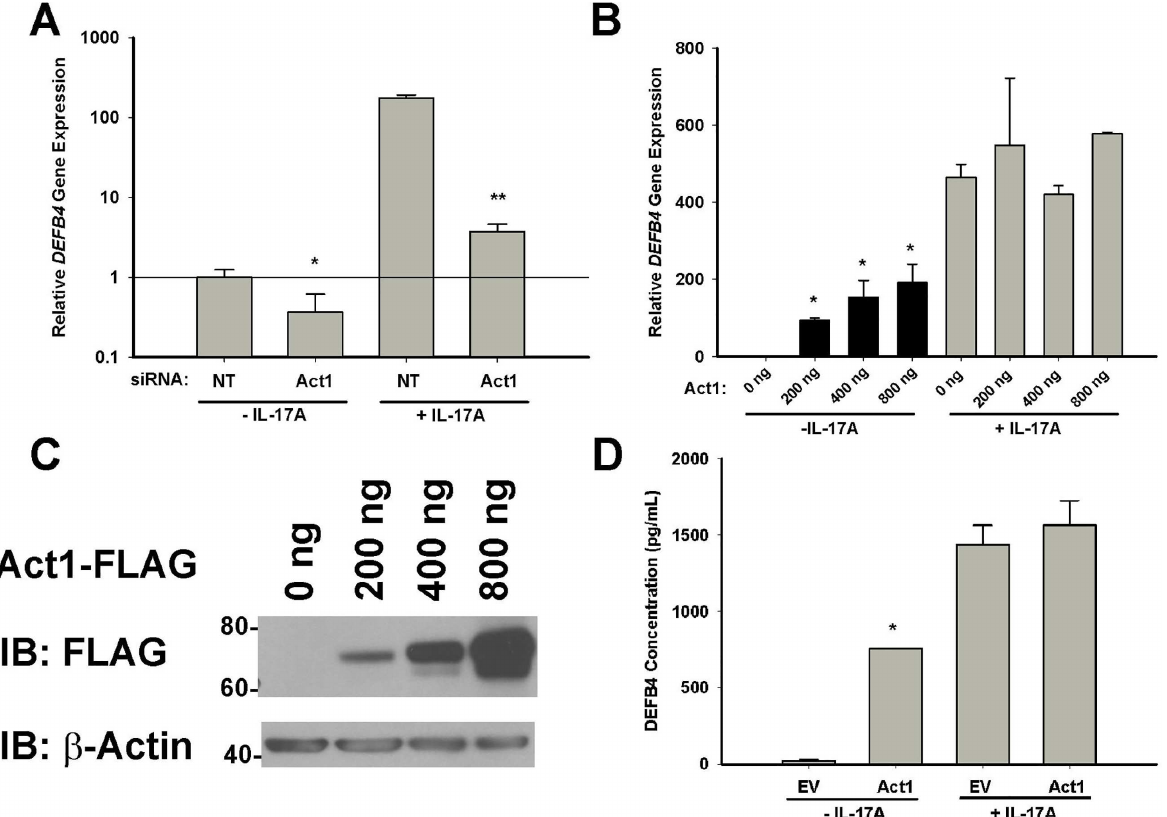
Fig 2. Act1 drives gene expression independent of IL-17 stimulation. (A) HBE1 cells were transfected with Act1 siRNA or a non- targeting (NT) siRNA control. 48h post transfection, cells were treated with media only (-IL-17A) or 100 ng/mL IL-17A (+IL-17A) for an additional17h, then harvestedfor RNA extraction and real-time PCR analysis of DEFB4 expression. C(t) values were normalizedto a housekeeping gene, GAPDH , and calibratedto NT siRNA/-IL-17A. Error bars represent SEM of 3 independent experiments. * p < 0.05 compared to NT siRNA/-IL-17A samples, ** p < 0.05compared to NT siRNA/+IL-17A samples. (B) HBE1 cells were transfected with increasingamounts of Act1-FLAG plasmid. Total transfected DNA was normalizedusing p3XFLAG-CMV-14. 24h post-transfection, cells were treated with media only or 100 ng/mL IL-17A for an additional 17h, then harvestedfor RNA extraction and real-time PCR analysis of DEFB4 expression. * p < 0.05 compared to 0 ng transfected (mock transfection) (C) To confirm increasingAct1-FLAG protein expression, 30 μ g whole cell extracts from transfected cells were analyzedby Western blot for Act1-FLAG. β -actin was used as a loadingcontrol. (D) DEFB4 protein was quantitatively measured in cell culture supernatant by ELISA (n = 3). * p < 0.05 compared to empty vector (EV) transfected